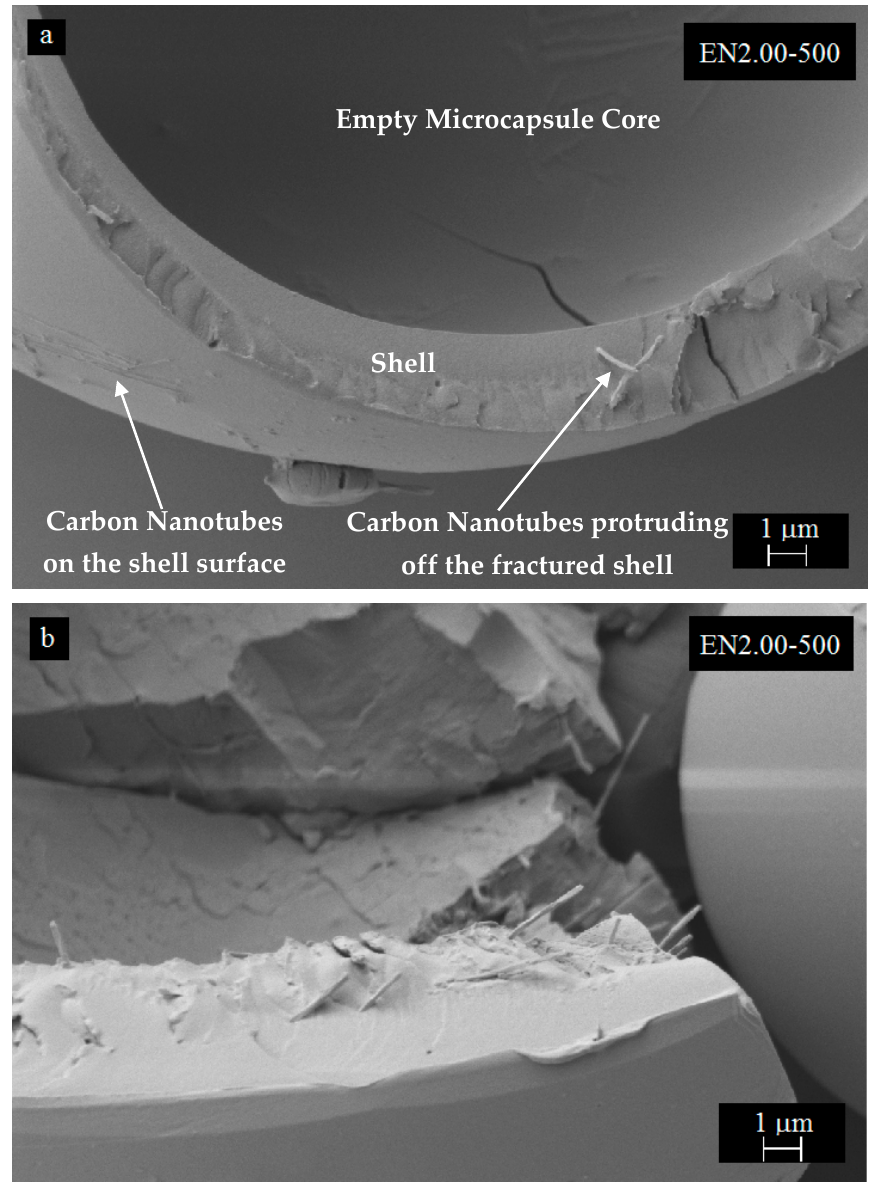
Figure 11. SEM micrographs of microcapsule formed with 2 wt % CNT: ( a ) Close view of the capsule interior surface and shell structure, and ( b ) CNT presence in the fractured shell.